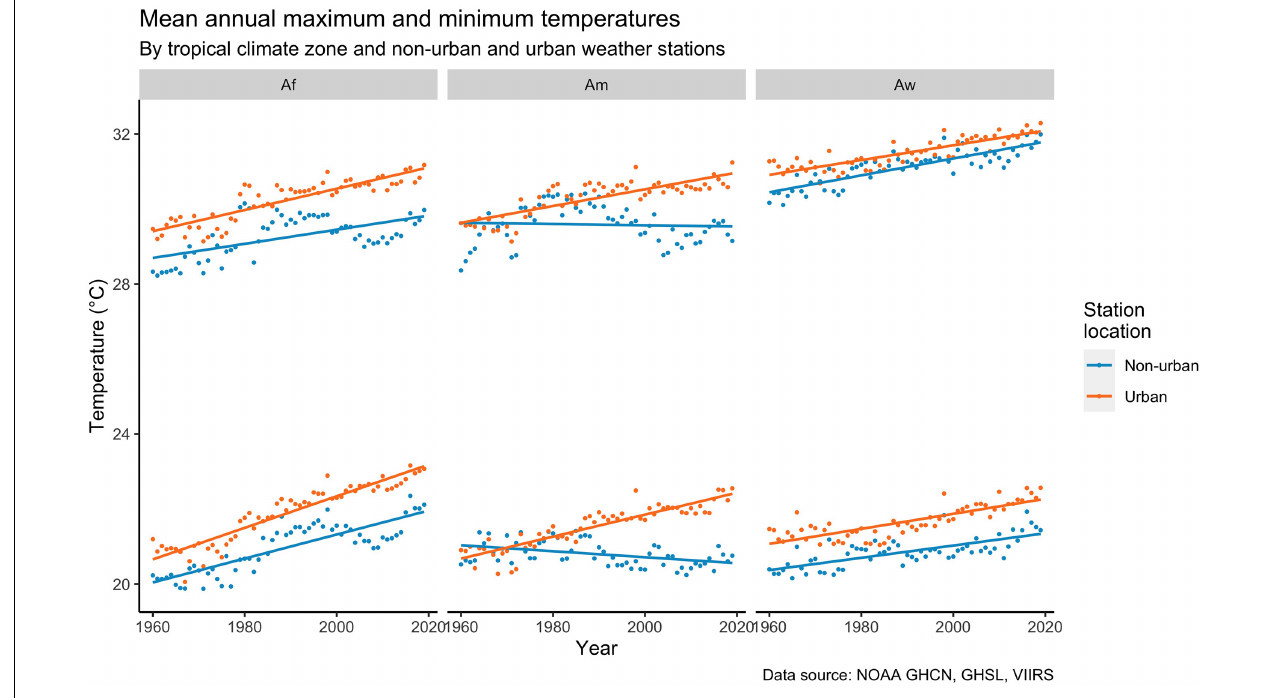
FIGURE 8 | Mean annual maximum and minimum temperatures for urban and non-urban areas by tropical zone. The higher points and curves on each mini-plot represent the maximum temperatures and the lower points and curves represent the minimum temperatures. Data source: NOAA,